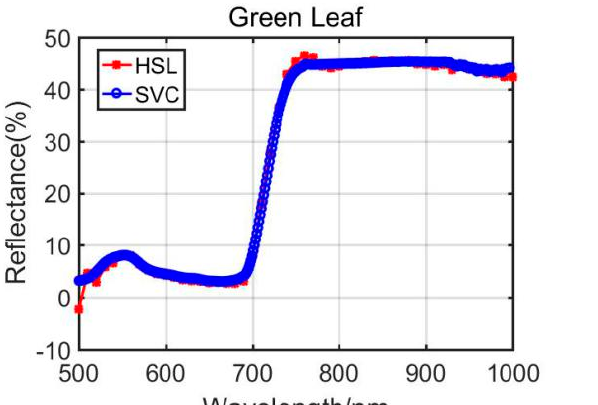
Table 4. Spectral indexes results